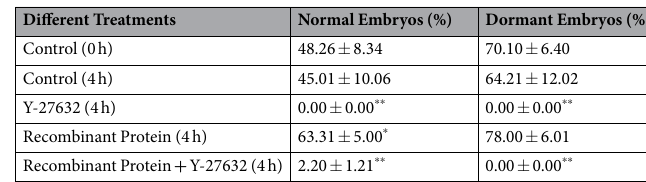
Table 1. Survival rates after freezing-thawing of blastocysts, co-cultured with recombinant protein RhoA and its inhibitor, as indicated. Note: The data are presented as the means ± SEM. ** p < 0.01 was considered remarkable statistically significant in same column; * p < 0.05 was considered statistically significant in